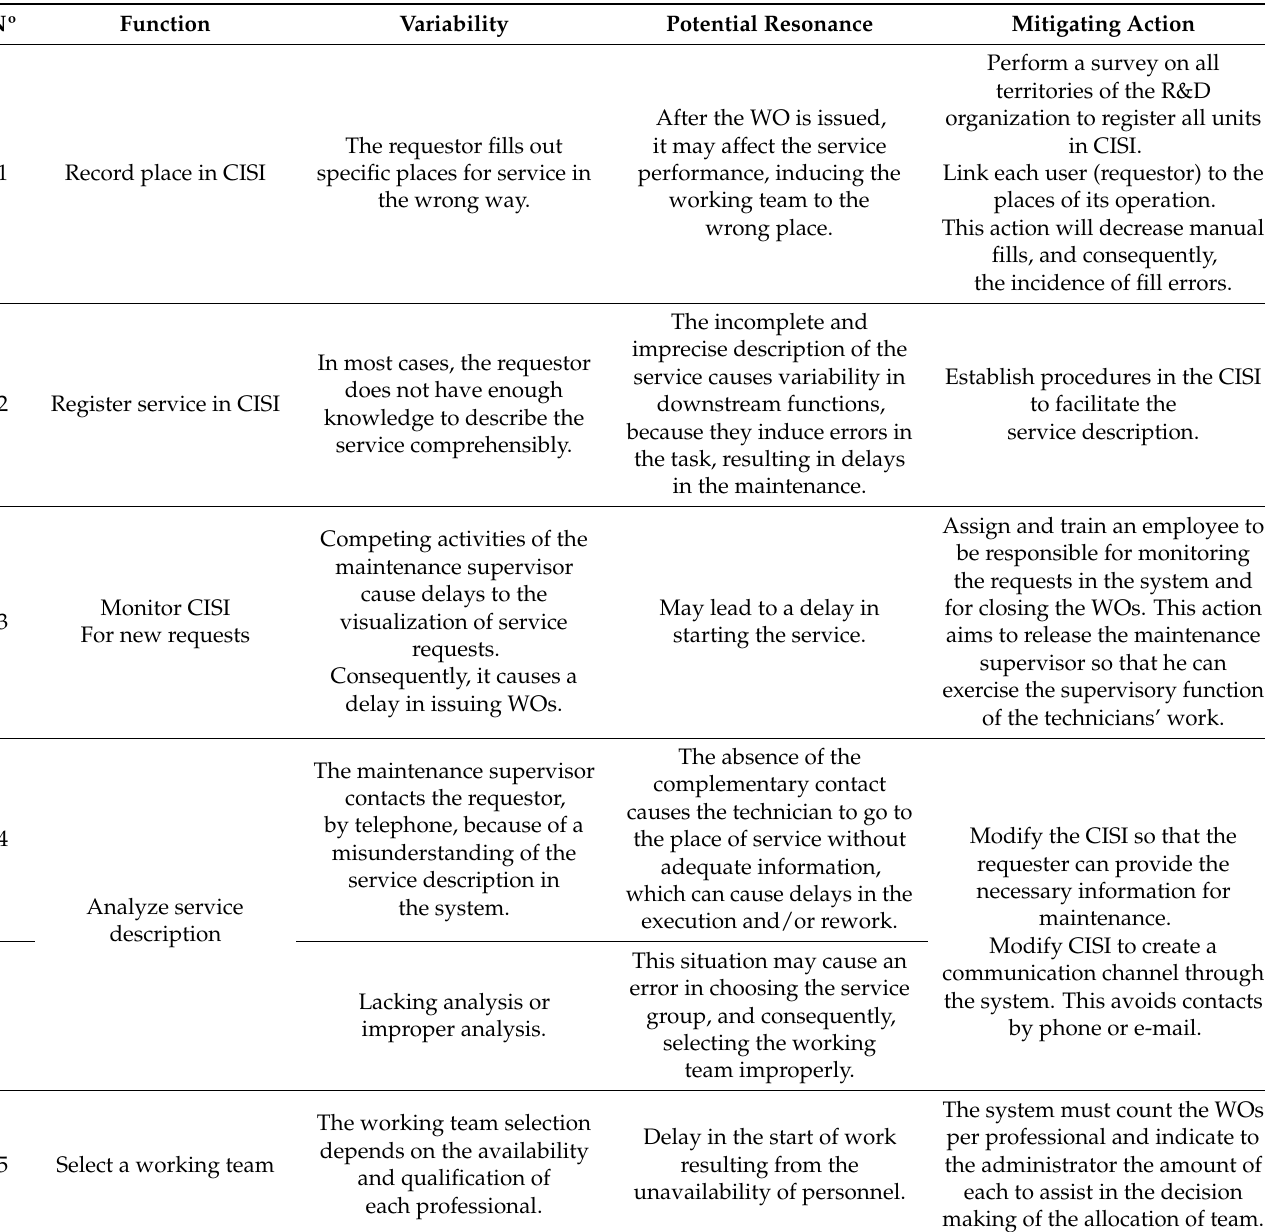
Table 2. Mitigating actions proposed for potential variability, aiming to establish requirements for redesigning the Informa- tion technology (IT)